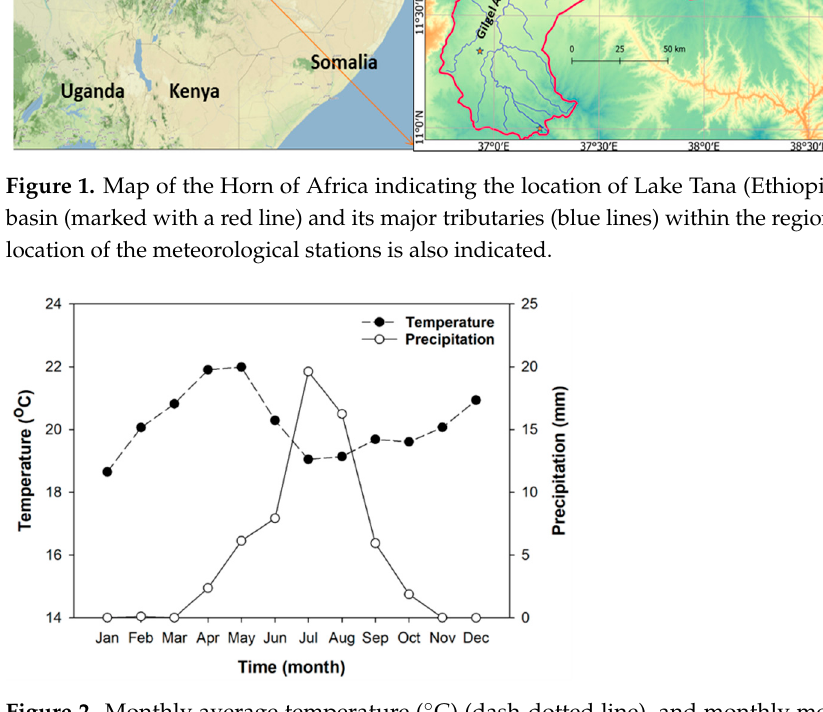
Figure 2. Monthly average temperature (°C) (dash ‐ dotted line), and monthly mean precipitation (mm) (solid line) in Lake Tana during 2020.